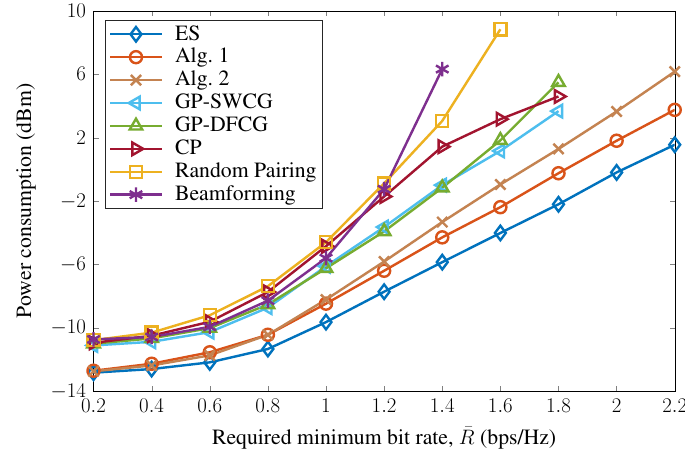
Figure 5. Power consumption versus minimum bit rate.